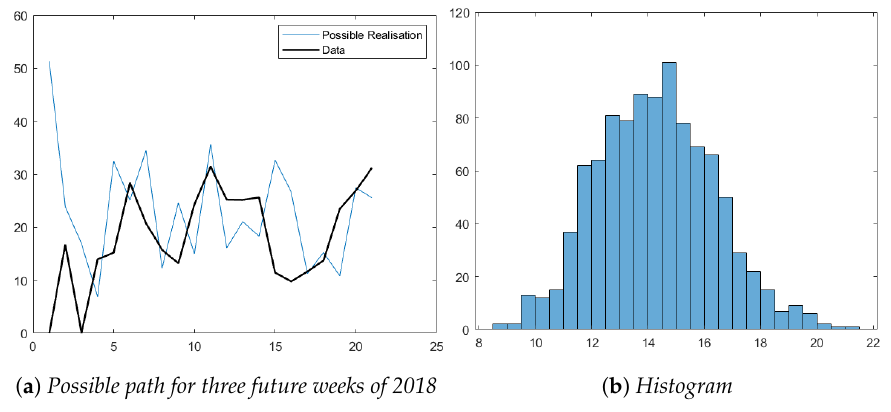
Figure 14. From PDF to the stochastic process.